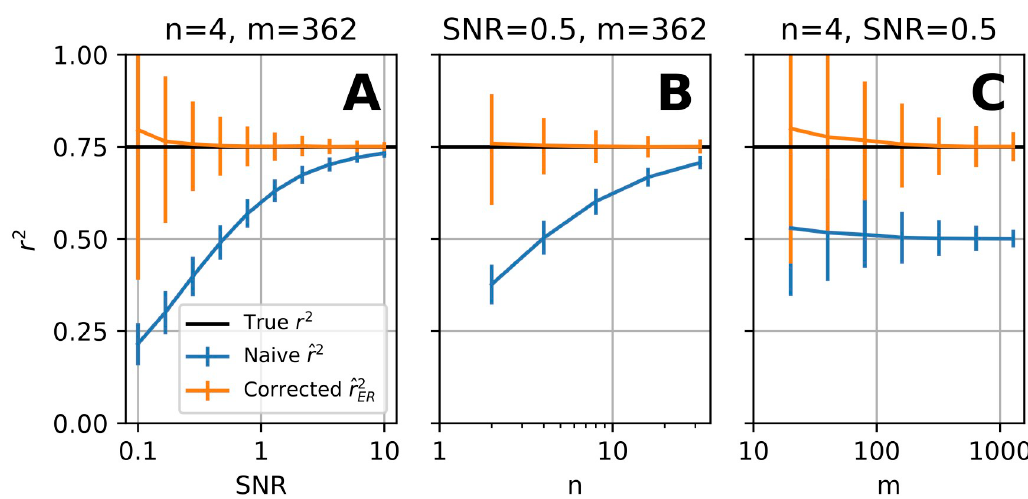
Fig 3. Comparison of ^ r 2 and ^ r 2 for estimating model-to-neuron fit across broad, relevant ranges of SNR, n , and m . (A) ER Average performance of naive ^ r 2 (blue) and corrected ^ r 2 (orange) as a function of SNR for a simulation where true r 2 ER (horizontal black line), m = 362, n = 4, and σ 2 = 0.25. Error bars indicate 90% quantiles. (B) Performance of estimators as a function of n , the number of repeats of each stimulus. Simulation like (A), except SNR = 0.5 and n is varied. (C) Performance as a function of m , the number of unique stimuli, for a low number of repeats ( n = 4). Like (A), except SNR = 0.5 and m is varied.